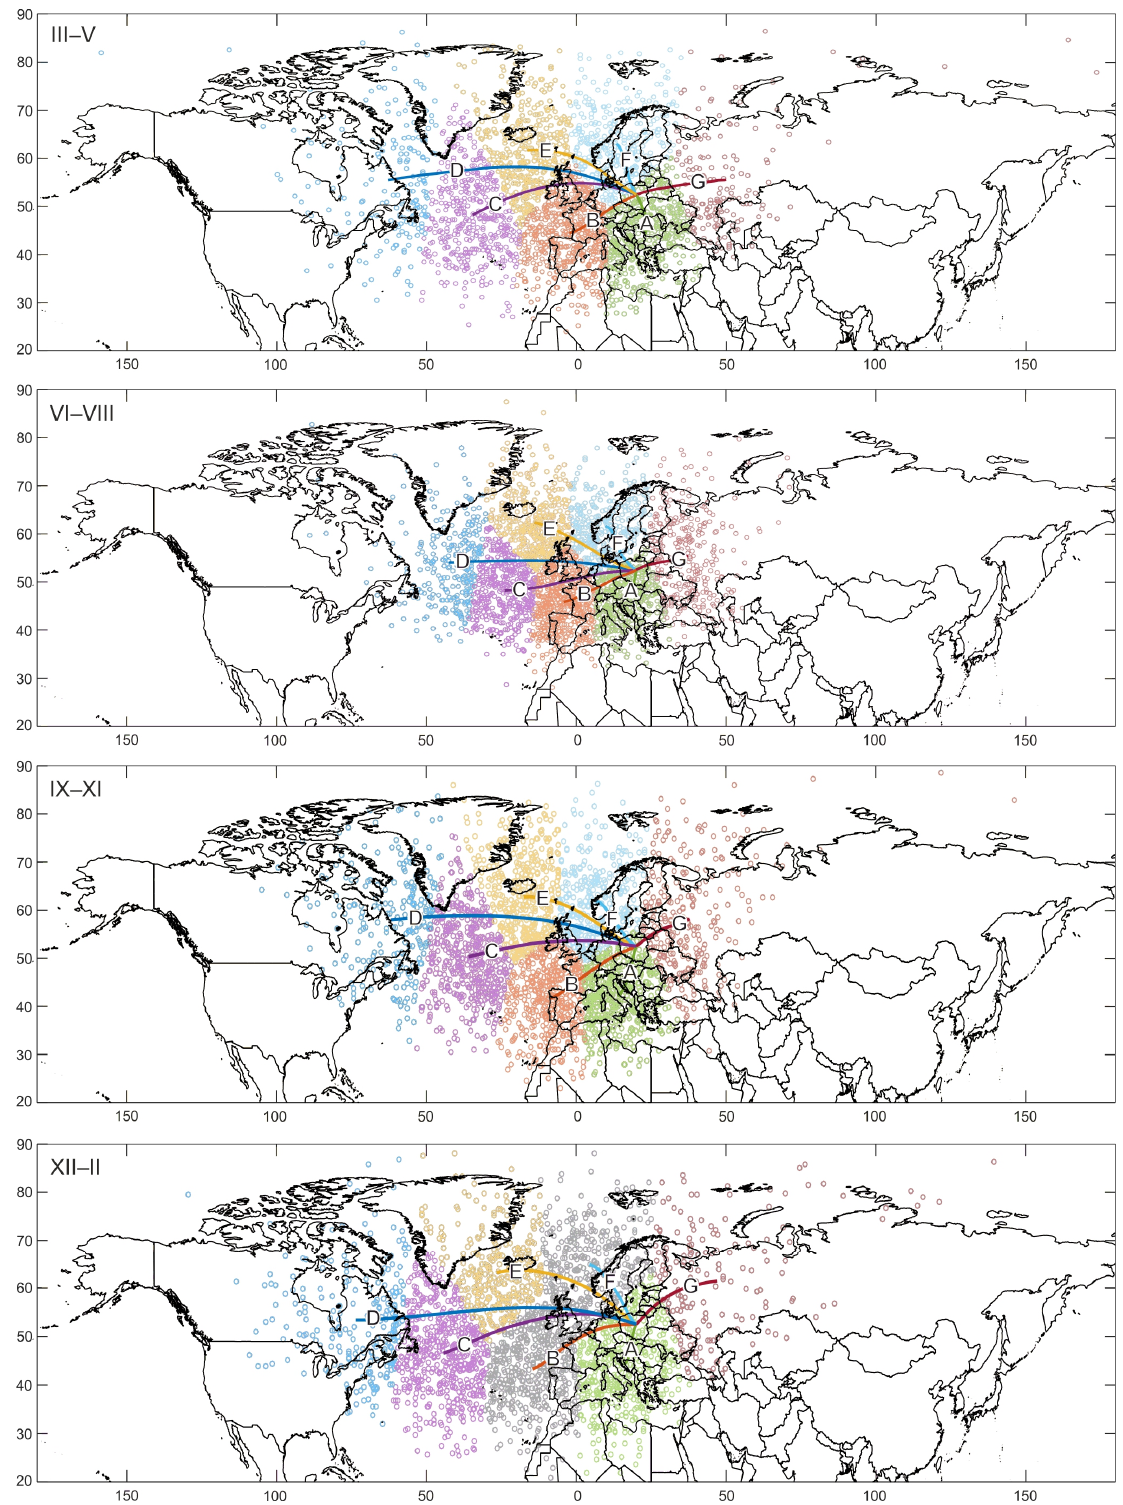
Figure 3. Averaged 72 ‐ h backward trajectories in 7 clusters ending at the grid point 52.5° N, 20° E at 12:00 UTC at 3000 m above ground level, in individual seasons of the year during the period 1986– 2015 and clustered starting points of all backward trajectories in individual seasons of the year in the period 1986–2015.